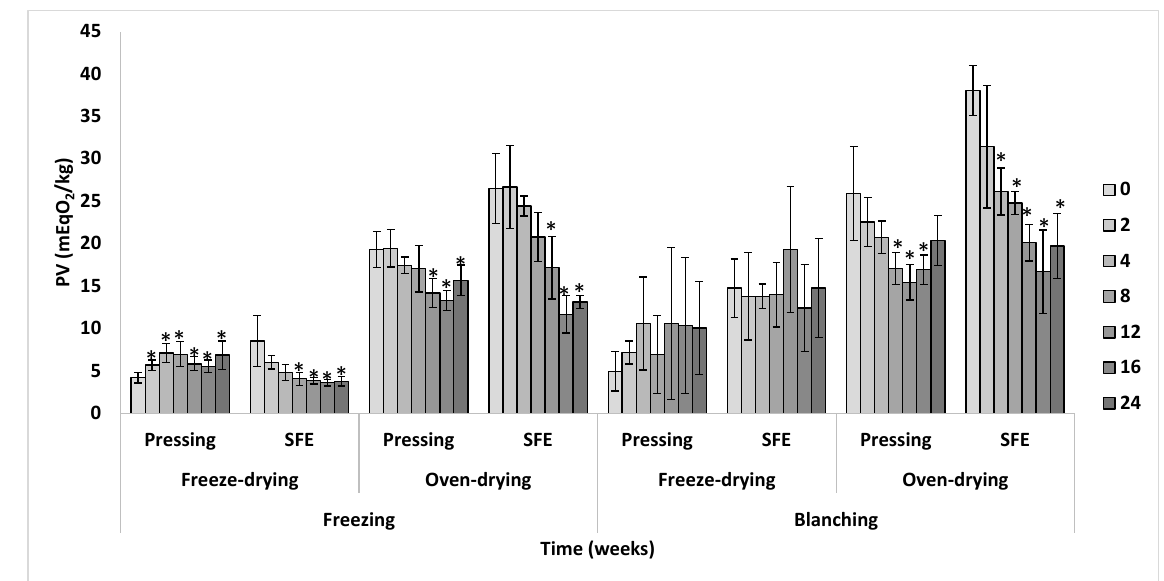
Figure 7. Oxidative stability (PV) during storage of the defatted meals from BSFL processed by different methods of slaughtering, drying, and defatting. Samples with an asterisk within each treatment mean significant difference with respect to its respective initial value at week 0. Each data point corresponds to mean values ± SD, n = 4.